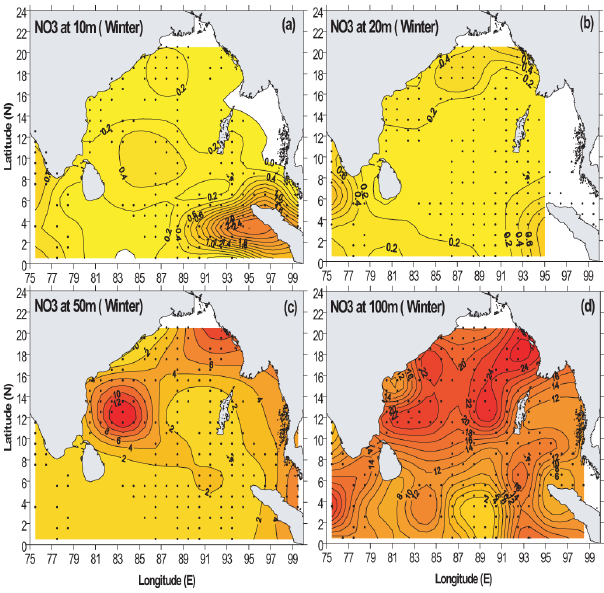
Figure 14. Spatial distribution of nitrate (µM) at (a) 10, (b) 20, (c) 50, and (d) 100m during winter monsoon. Note the change in contour interval in (c) and (d) .